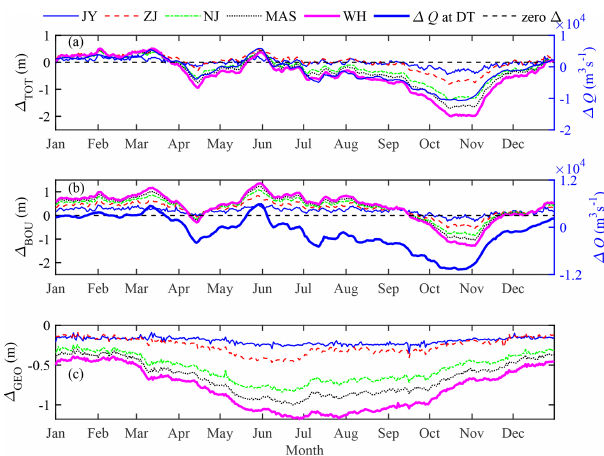
Figure 6. Alterations in water levels induced by the combined im- pacts of natural and anthropogenic changes (cid:49) TOT (a) , boundary condition changes (cid:49) BOU (b) , and geometric changes (cid:49) GEO (c) at different gauging stations along the upper